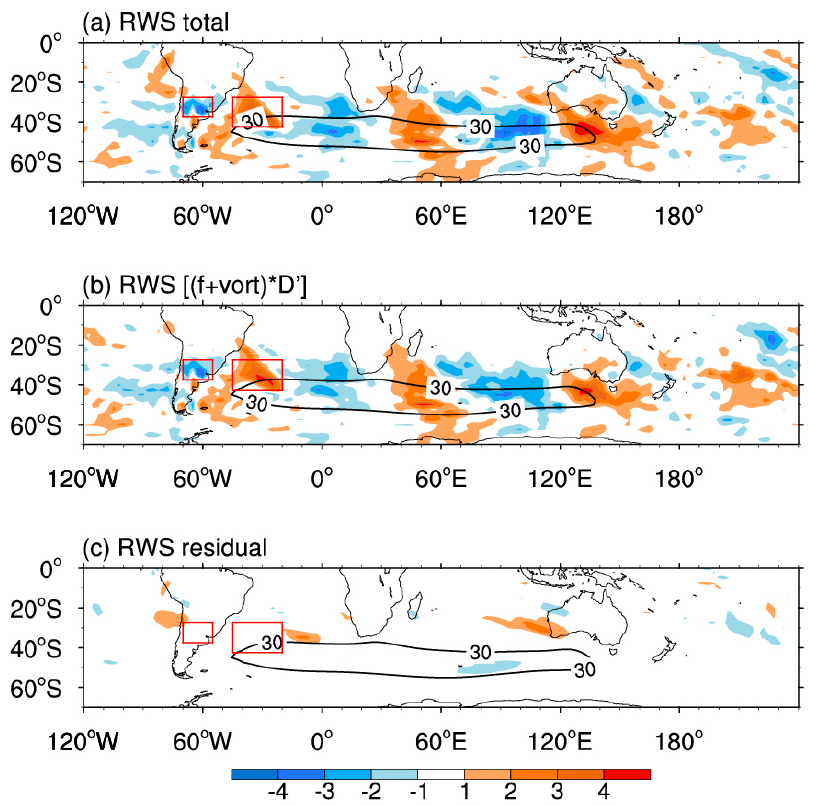
Figure 7. ( a ) Rossby wave source (RWS, unit: 10 − 11 s − 2 ) total, ( b ) RWS induced directly by anomalous divergence, and ( c ) the residual RWS associated with the SAIO pattern. See text for more details. The boxes depict the two key forcing regions for the SAIO pattern and the contour depicts the Southern Hemisphere